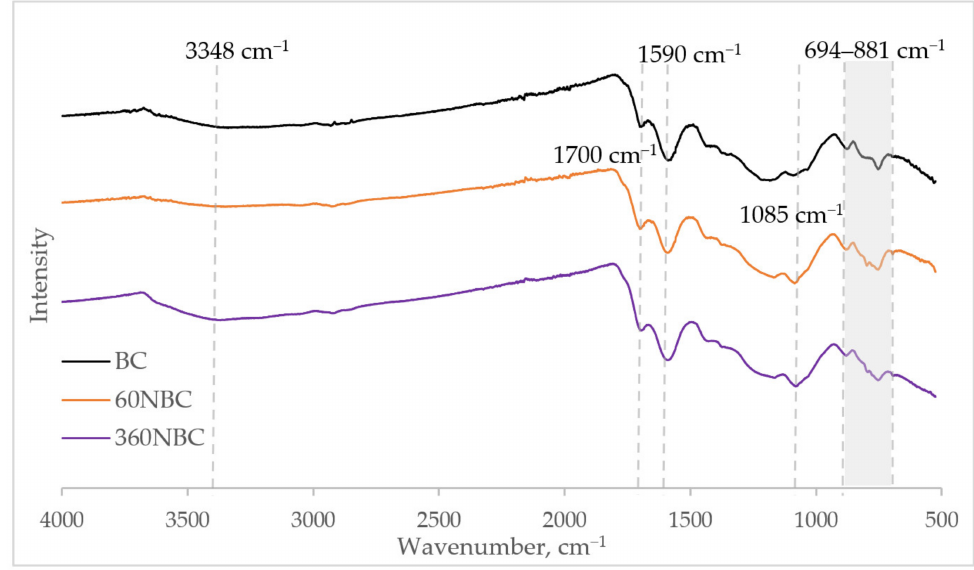
Figure 6. FTIR spectra of BC, 60NBC, and